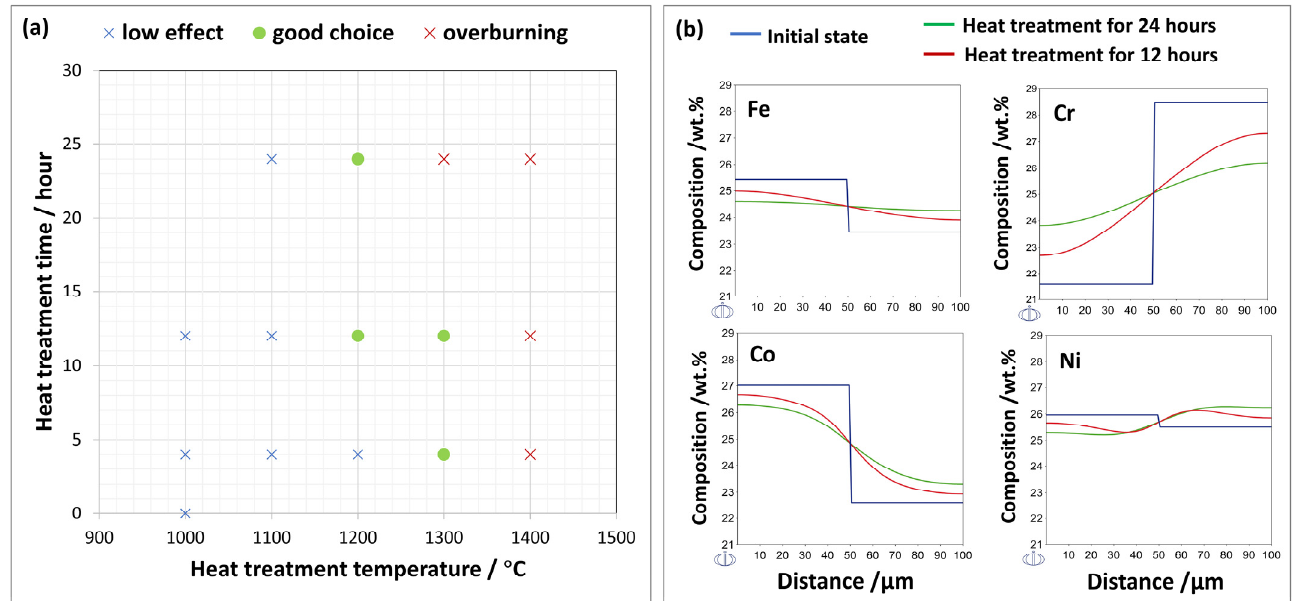
Figure 11. Calculated elements deviation after different heat treatment parameters by the Scheil back diffusion module and DICTRA software: ( a ) reasonable post-heat treatment region, ( b ) elements distribution after heat treatment of 1200 °C.